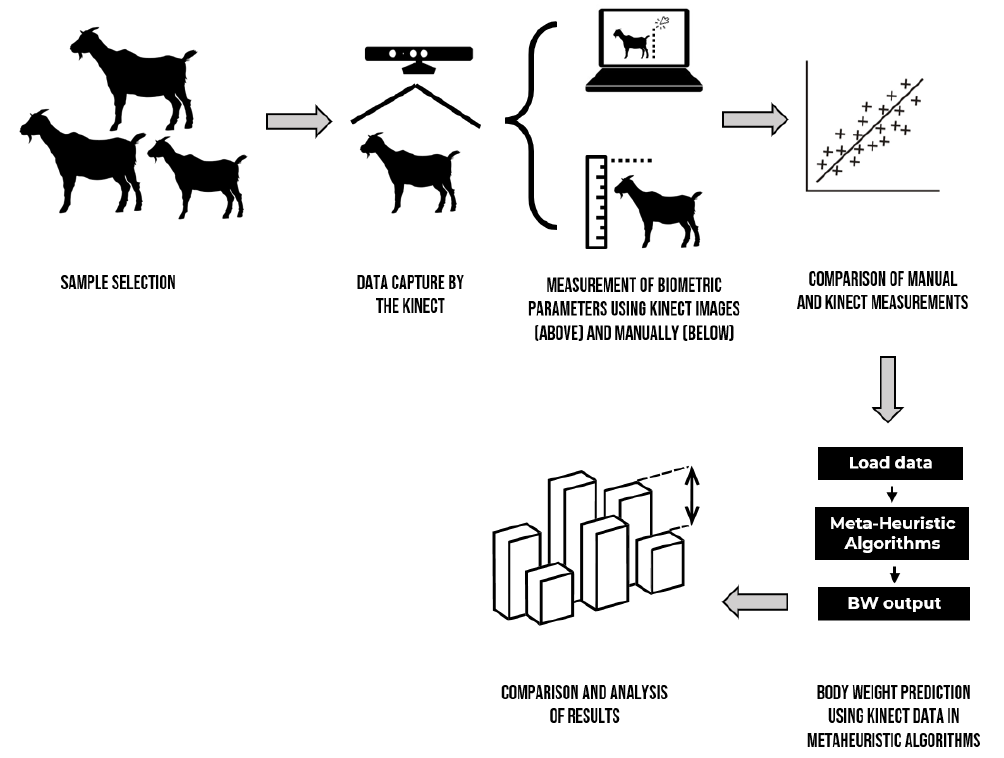
Figure 1. Workflow of the main stages carried out in this